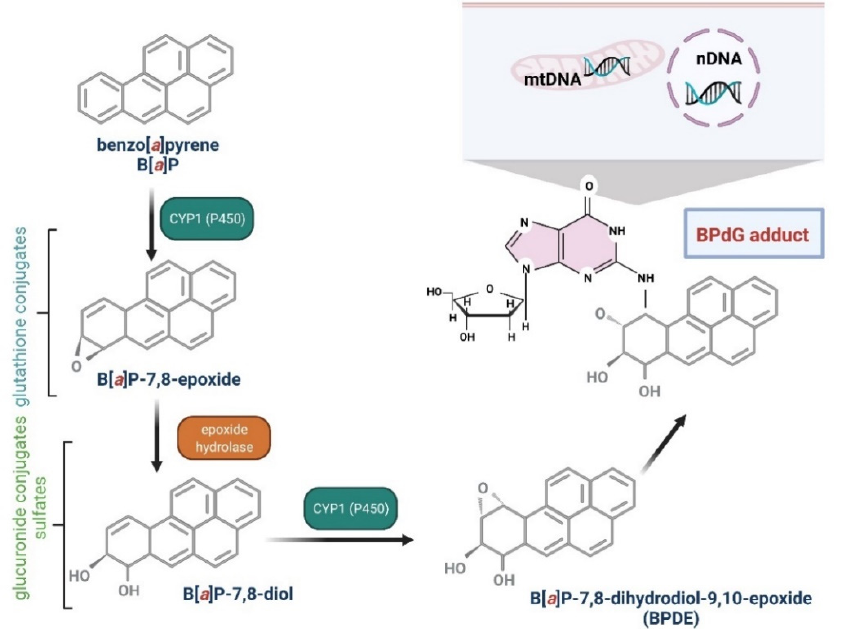
Figure 3. Biotransformation of B[ a ]P into mutagen. B[ a ]P in the I phase of detoxification goes through several stages, giving various derivatives, including B[ a ]P-7,8-diol-9,10-epoxide, that are able to react with DNA guanine. The reaction results in the formation of adducts with DNA (mtDNA, mitochondrial DNA; nDNA, nuclear DNA) and mutations [80,81]. Created with BioRender.com (accessed on 12 April